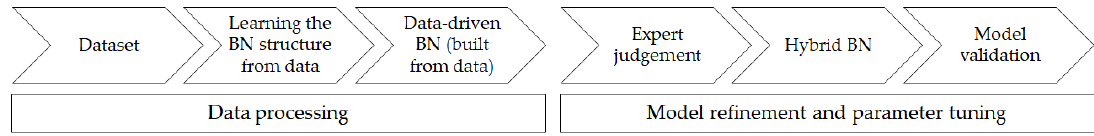
Figure 13. BN construction process.